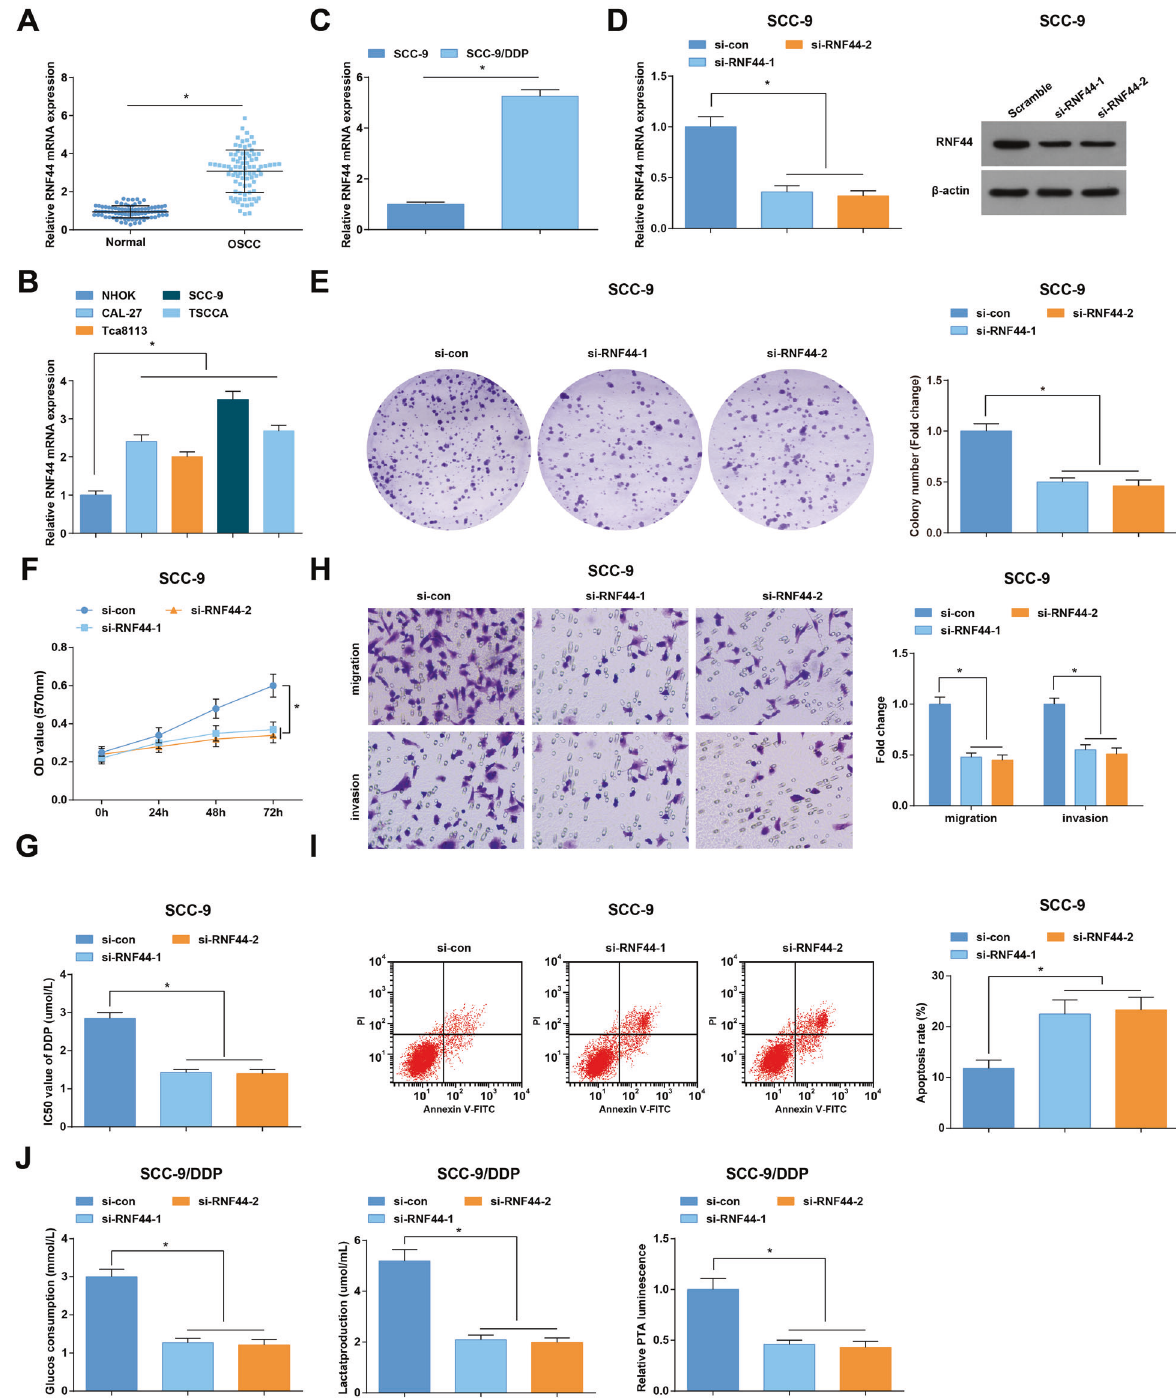
Fig. 5 RNF44 affects growth, DDP sensitivity, and glycometabolism of OSCC cells. A RNF44 mRNA expression in clinical samples was assessed using RT-qPCR ( n = 85); B RNF44 mRNA expression in NHOK and OSCC cell lines was assessed using RT-qPCR; C RNF44 mRNA expression in SCC-9 and SCC-9/DDP cells was assessed using RT-qPCR; D two effective si-RNF44 were designed to knockdown the expression of RNF44 and its interference ef fi ciency was detected by RT-qPCR and western blot analysis in SCC-9 cells; E colony formation ability of SCC-9 cells was determined using colony formation assay after transfection of si-RNF44; F viability of SCC-9 cells was determined using MTT assay after transfection of si-RNF44; G IC 50 of SCC-9 cells was determined using MTT assay after transfection of si-RNF44; H migration and invasion of SCC-9 cells was detected using Transwell assay after transfection of si-RNF44; I apoptosis of SCC-9 cells was detected using fl ow cytometry; J glycometabolism of SCC-9/DDP cells was analyzed after transfection of si-RNF44; N = 3; * P < 0.05; Data were expressed as mean ± standard deviation; t -test or ANOVA was used to analyze data.